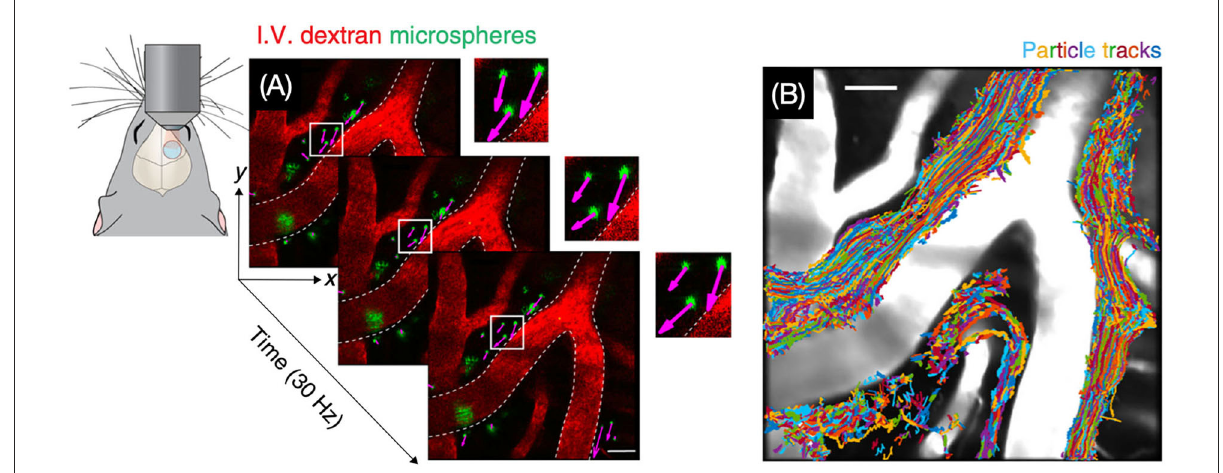
FIGURE7 Visualization of CSF bulk flow in the perivascular space through two-photon microscopy. (A) Images for particle tracking velocimetry were acquired at 30Hz. (B) Trajectories of tracked microspheres were superimposed on the image, showing that particles are transported